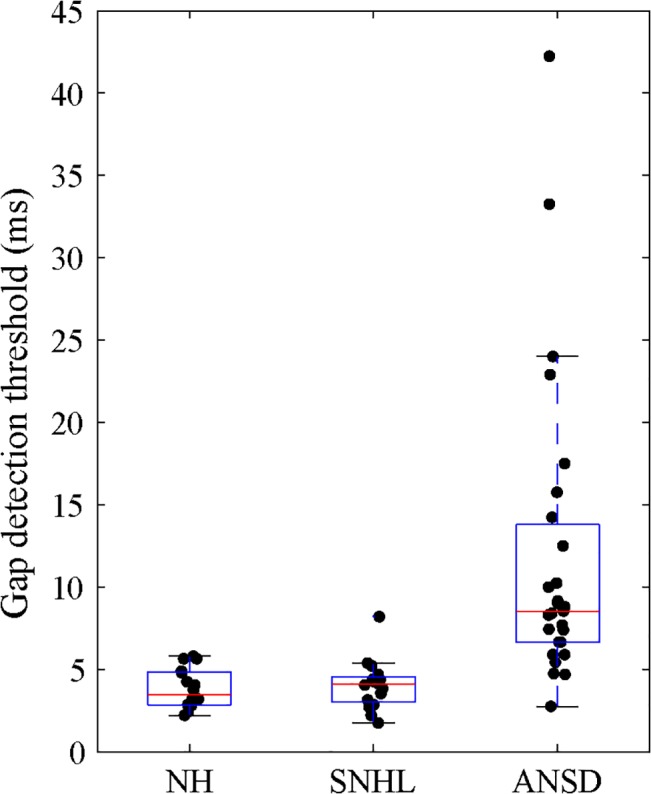
Temporal gap detection thresholds for subjects with NH, with SNHL, and with ANSD.The horizontal lines of the box represent 25th, 50th, and 75th percentiles and the whiskers represent the range of the data. Individual subjects are represented by the solid dot.